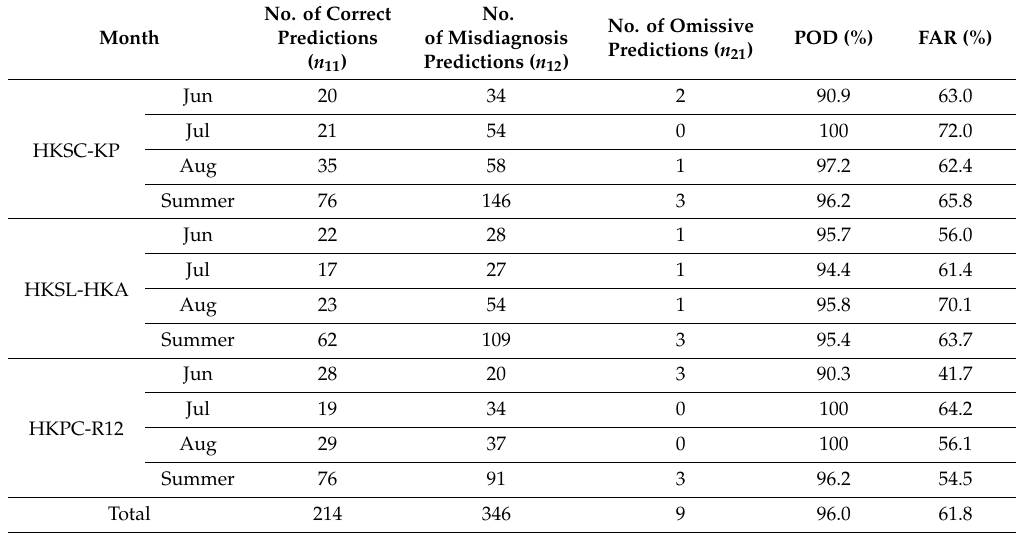
Table 10. Prediction results for the summer months in 2018 and 2019 from the 3-factor